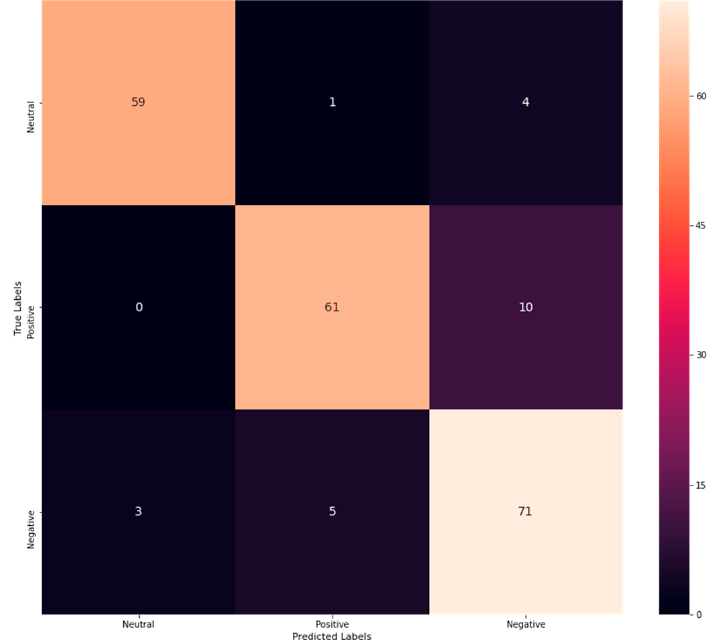
Figure 2. Confusion matrix of M-RF.